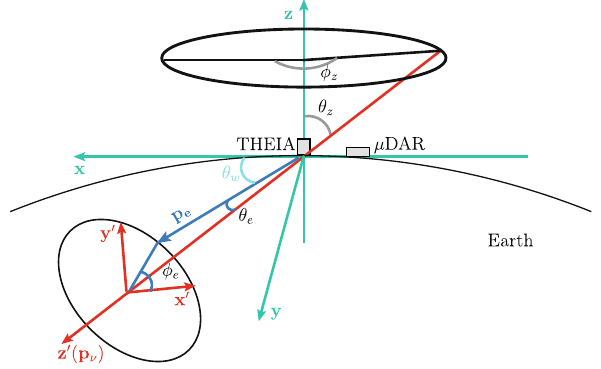
Fig. 17 Theschematicshowofthewrongscatteringangleeffectforthe measurement of atmospheric neutrinos. During the scattering process, the incoming neutrino with momentum p ν (long red arrow) becomes an electron/positron with momentum p e (blue arrow). The neutrino momentum( − p ν )isparameterizedby θ z and φ z inthelabframe(green) while the electron/positron momentum ( p e ) by θ e and φ e in the neutrino frame. Without knowing the incoming neutrino direction, the genuine scattering angle θ e is wrongly reconstructed as θ